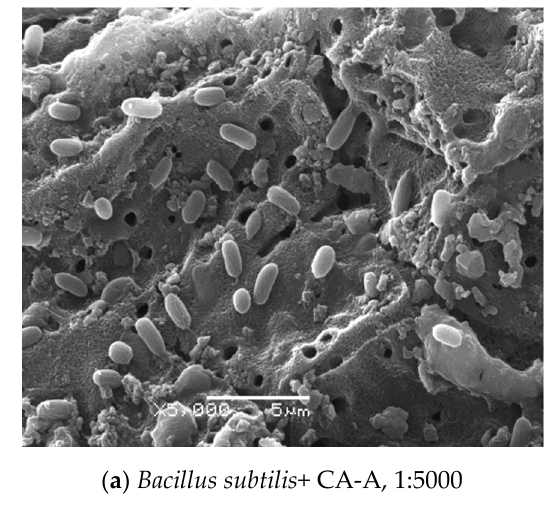
8 of 11 Table 3. Langmuir and Freundlich isotherm constants and correlation coefficients of B. subtilis and B. cereus adsorption capacity on AC-A. Bacteria